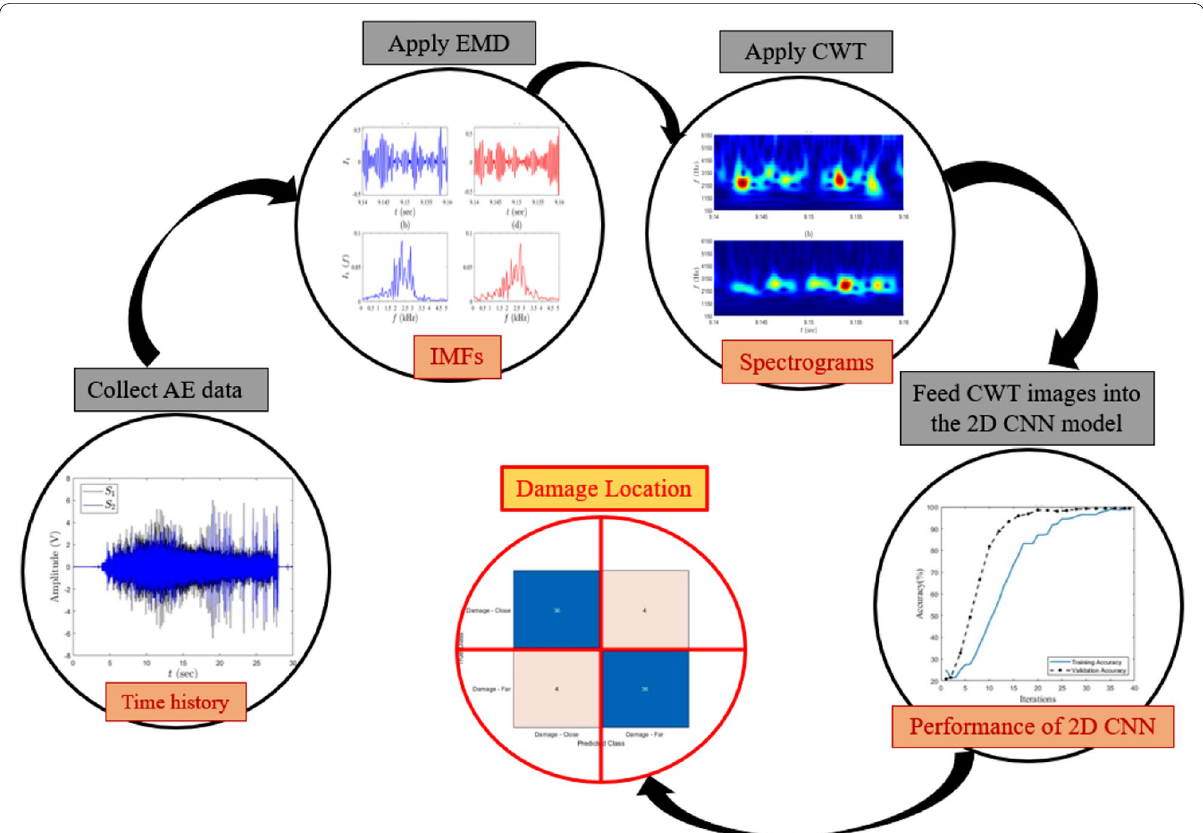
Fig. 4 Flowchart of the proposed